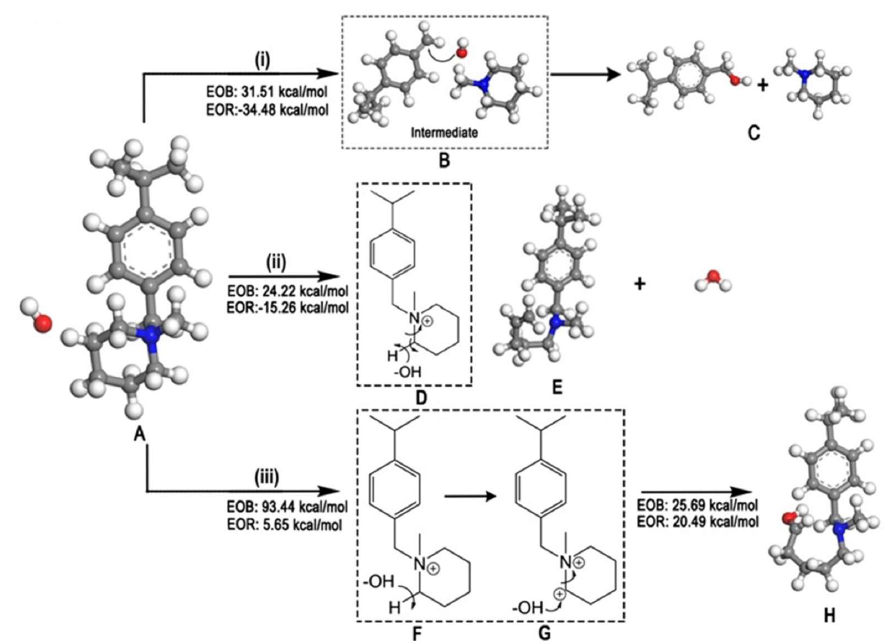
Figure 5. Degradation mechanism of N-methylpiperidine (NMP)-based AEM: ( i ) NMP head group detachment, ( ii ) ring-opening with subsequent formation of alkene, and ( iii ) ring-opening via direct hydroxylation. Reprinted with permission from [117]. Copyright 2020, for John Wiley and